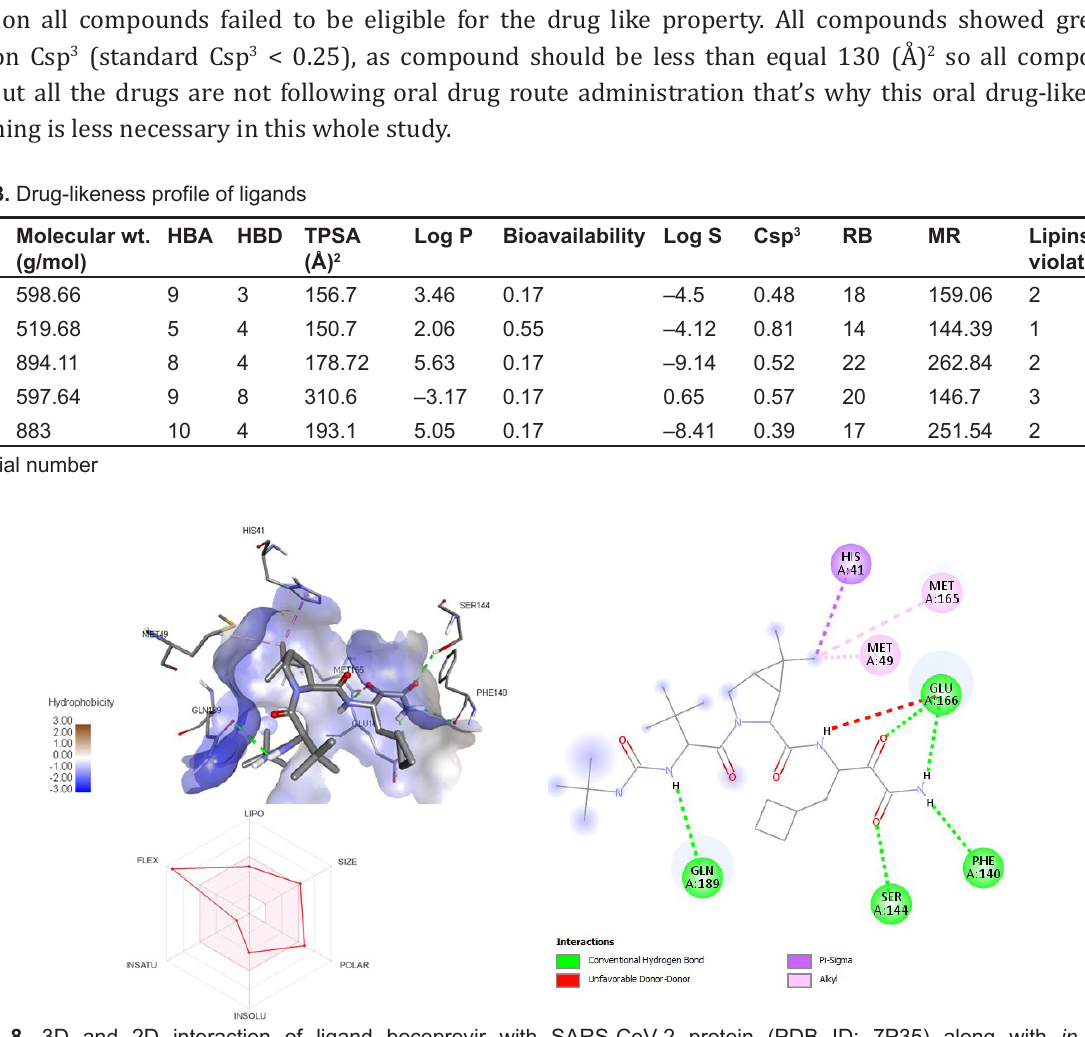
Figure 8. 3D and 2D interaction of ligand boceprevir with SARS-CoV-2 protein (PDB ID: 7P35) along with in silico ADMET